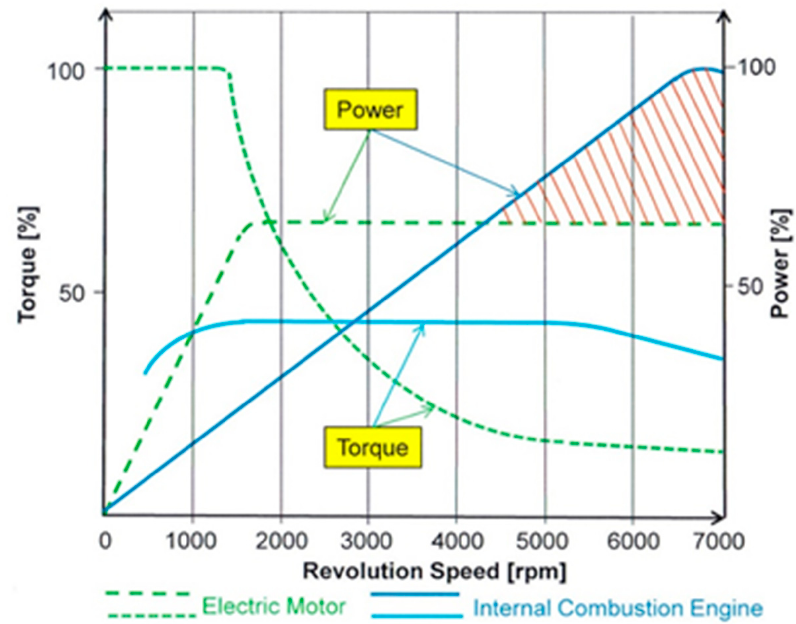
Figure 1. Comparison of ICE and electric motors (BEVs and FCEVs).